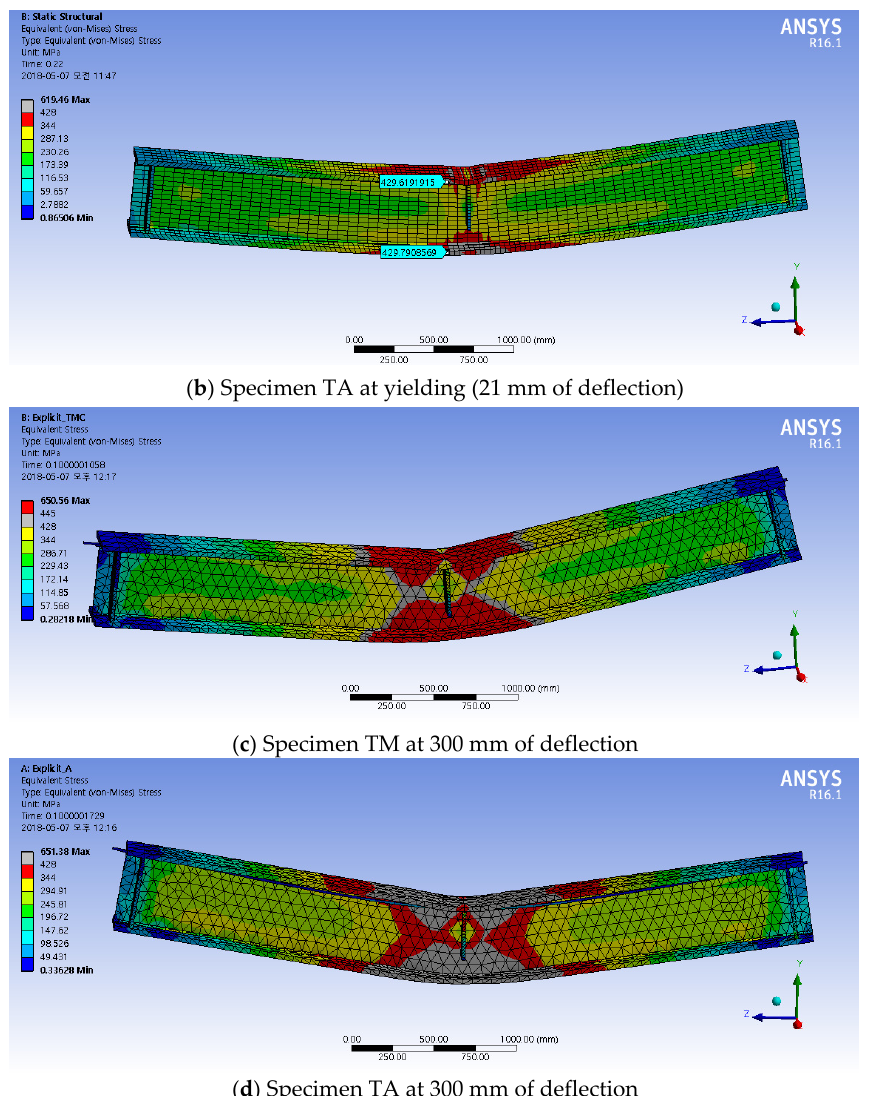
Figure 15. Stress distribution of analysis results.